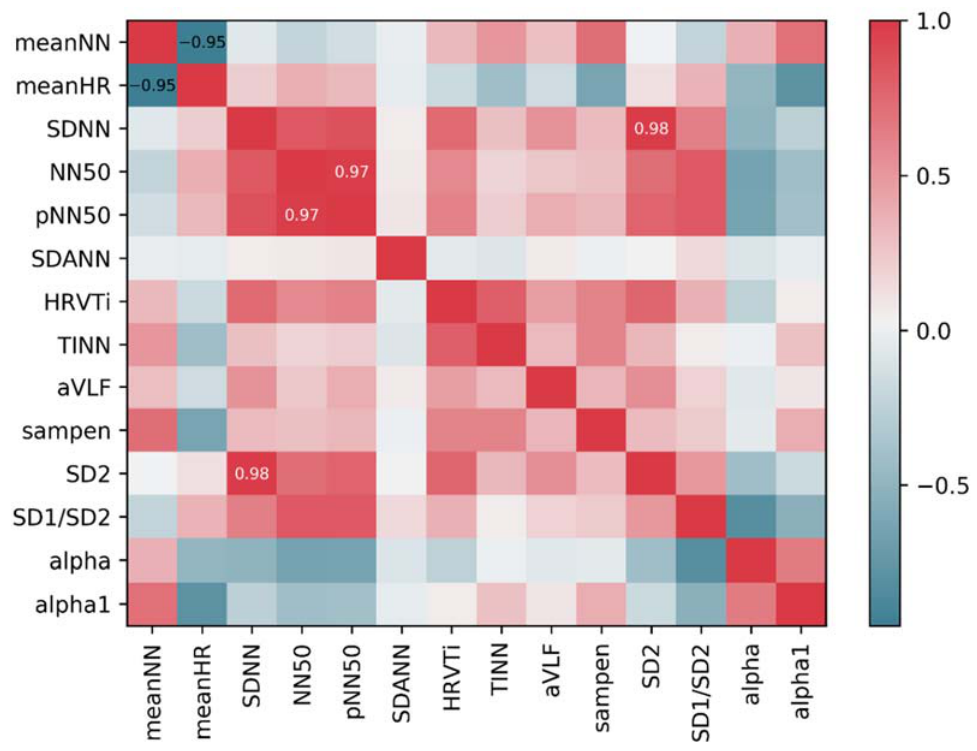
Figure 4. Correlations between 14 important features.